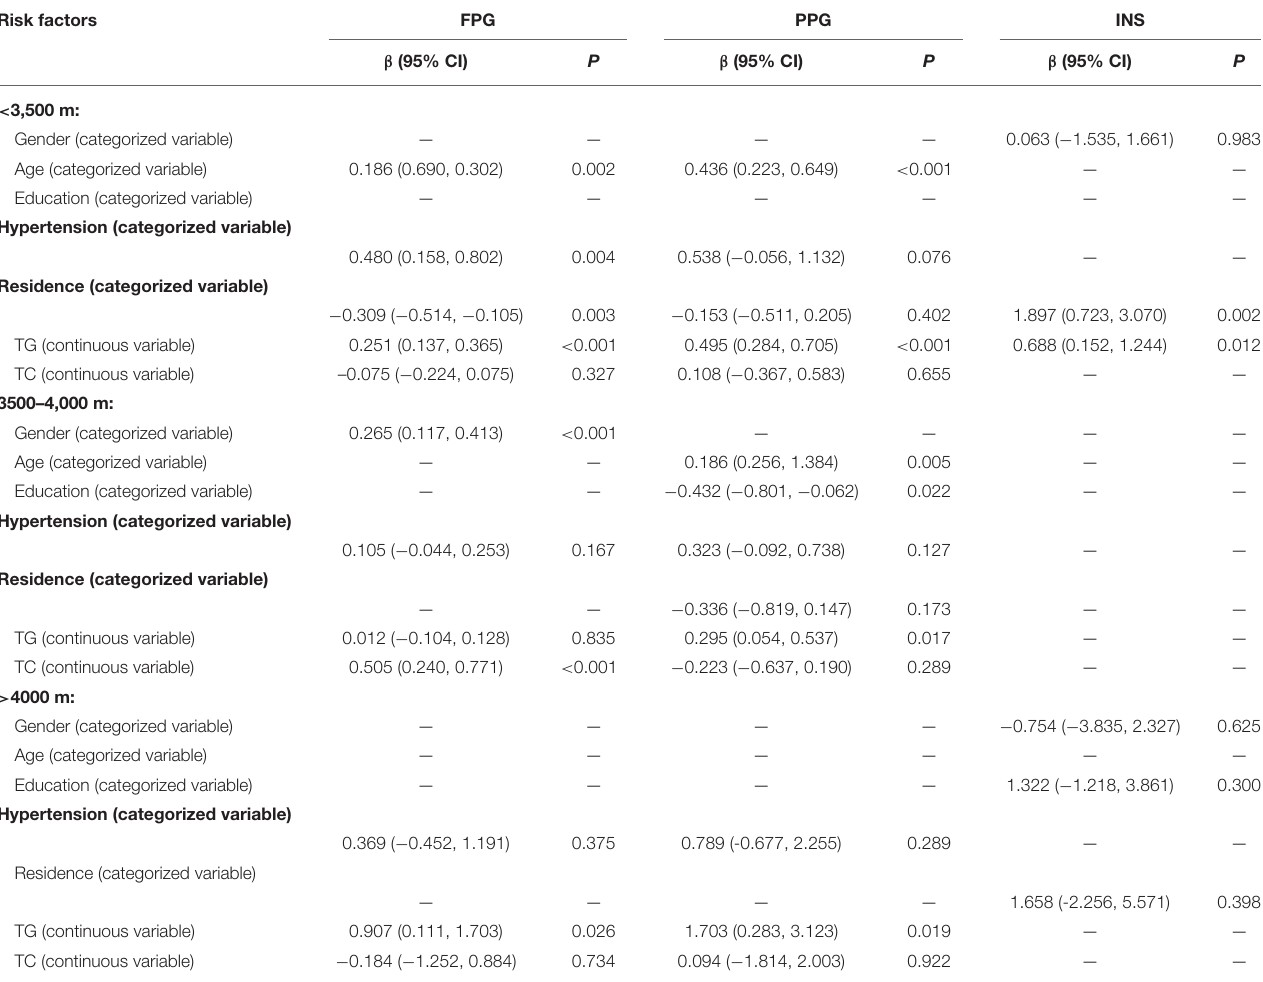
TABLE 5 | Determinants of FPG, PPG and INS at different altitude group. Risk